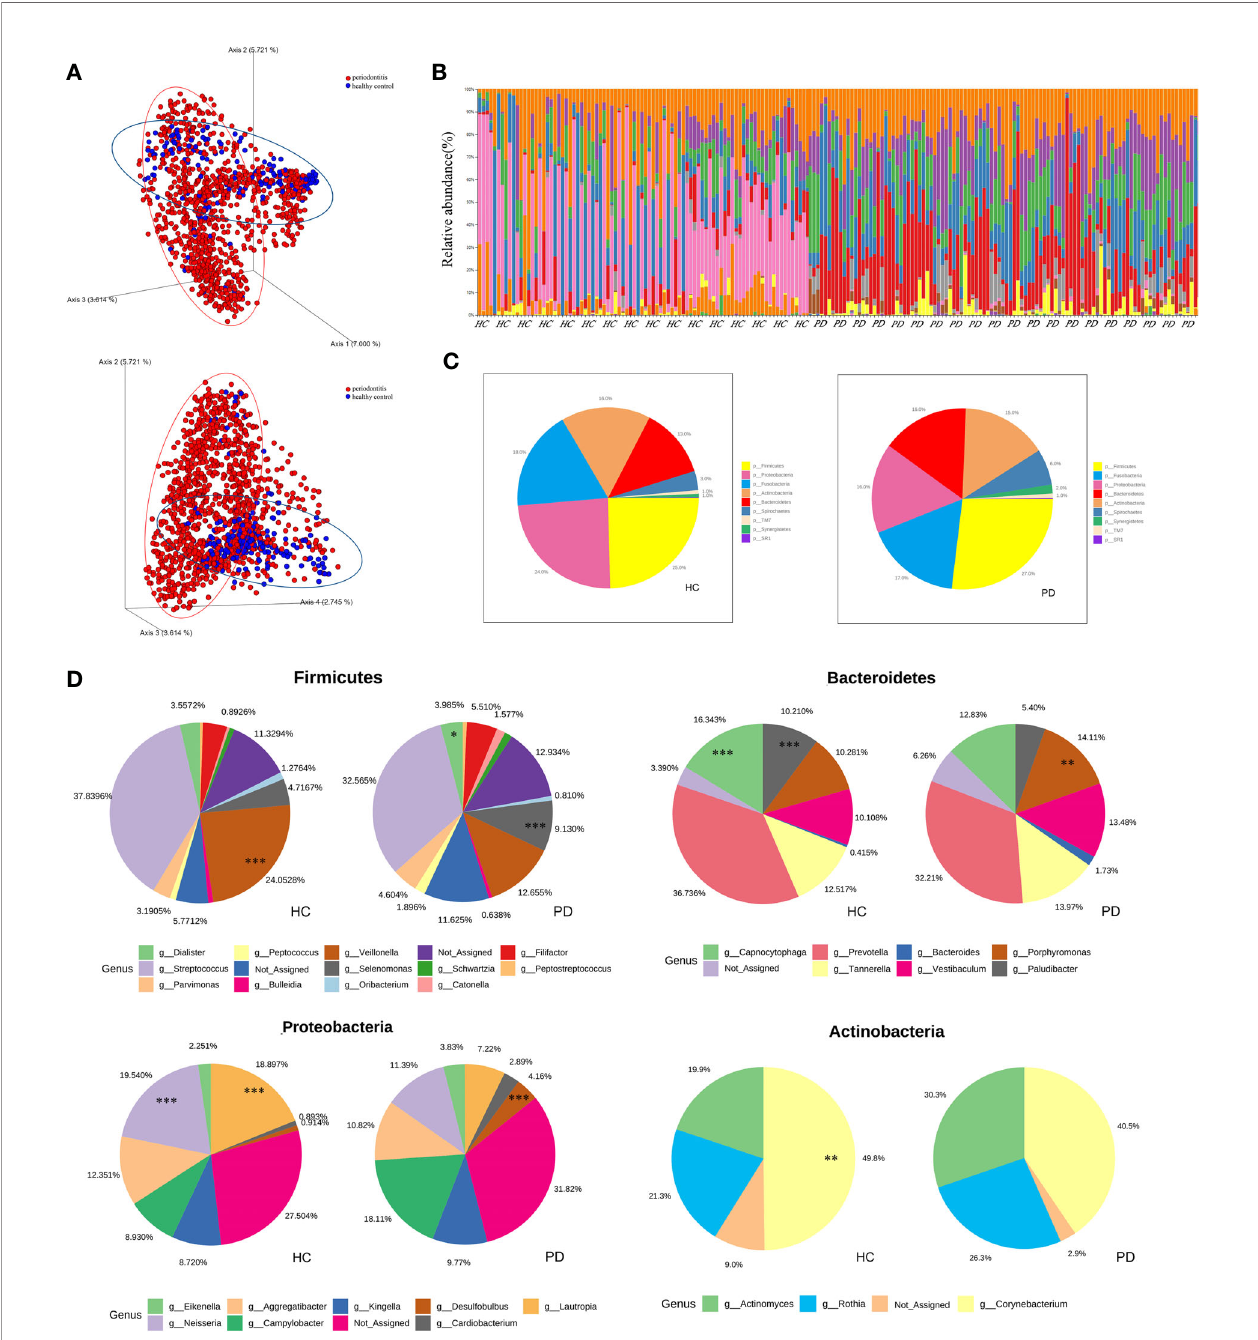
FIGURE 2 | (A) The 3D-PCoA plot based on Jaccard distance matrix (p<0.001, PERMANOVA) illustrates the beta diversity of oral microbiota. PD (periodontitis, red spots), HC (healthy control, blue spots). (B) The taxonomic bar plots on the phylum level. Each column represents a sample (HC left and PD right), and each small fragment in different colors represents different phyla. (C) The pie charts demonstrate the difference of microbial composition between HC (left) and PD (right) on the phylum level. Different colors correspond to the phyla on the list. (D) The subcategories composition of four phyla. Each pair of pie charts shows the comparison of microbial abundance between HC and PD on the genus level (*p < 0.05; **p < 0.01; ***p < 0.001, tested by RNA-seq methods, algorithm: regarded as a state of dysbiosis. The pie chart shows differences in A taxonomic bar plot was used to compare the pro fi le of HC and microbial composition between HC and PD on the phylum level PD groups at the phylum level ( Figure 2B ). It was observed that ( Figure 2C ). The dominant phyla of PD were Firmicutes (27%), the microbial community in PD was more complex than that in Fusobacteria (17%), Proteobacteria (16%), Bacteroidetes (16%), HC, and the proportions of several phyla changed, which was